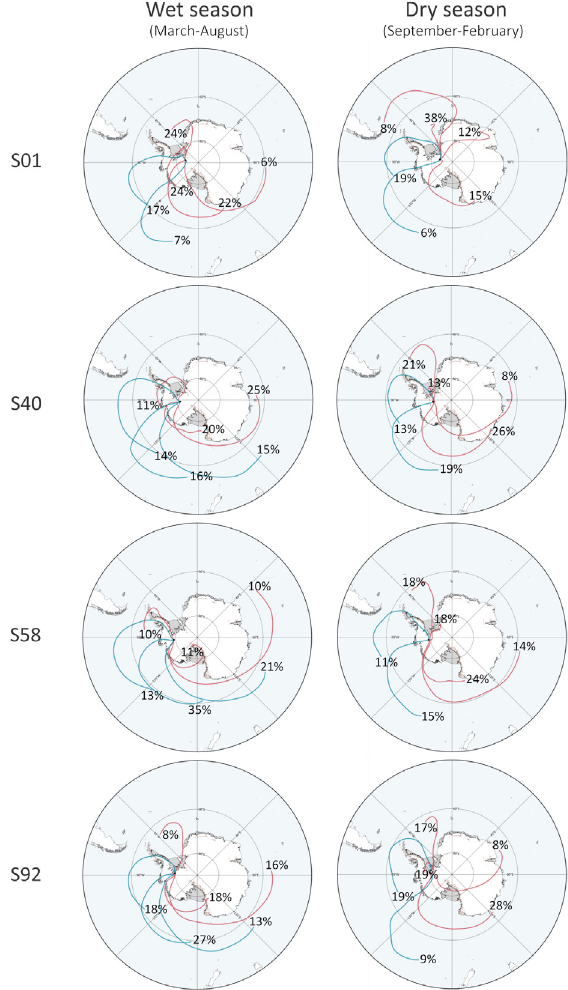
Figure 8. Air mass backward trajectory cluster analysis (10-days) by season: air-mass flow pattern for four sites in West Antarctica (S01, S40, S58, and S92) throughout 2014. The percentage of daily trajectories included in each cluster is indicated. The blue clusters represent oceanic air masses, and the pink ones are continental air masses. Trajectories and cluster analysis were performed using the NOAA HYSPLIT model (version 4.9) in conjunction with the NCEP/NCAR atmospheric reanalysis. Results were exported in Shapefile format. The base map is made in QGIS using the Quantarctica 3 Project datasets (Matsuoka et al.